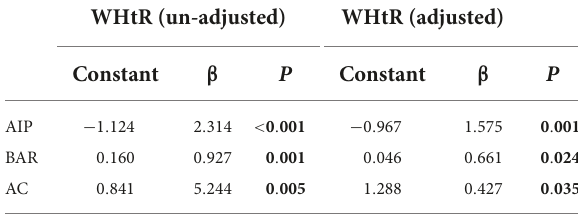
TABLE 5 Independent correlation analysis of cardiovascular risk predictors with WHtR.